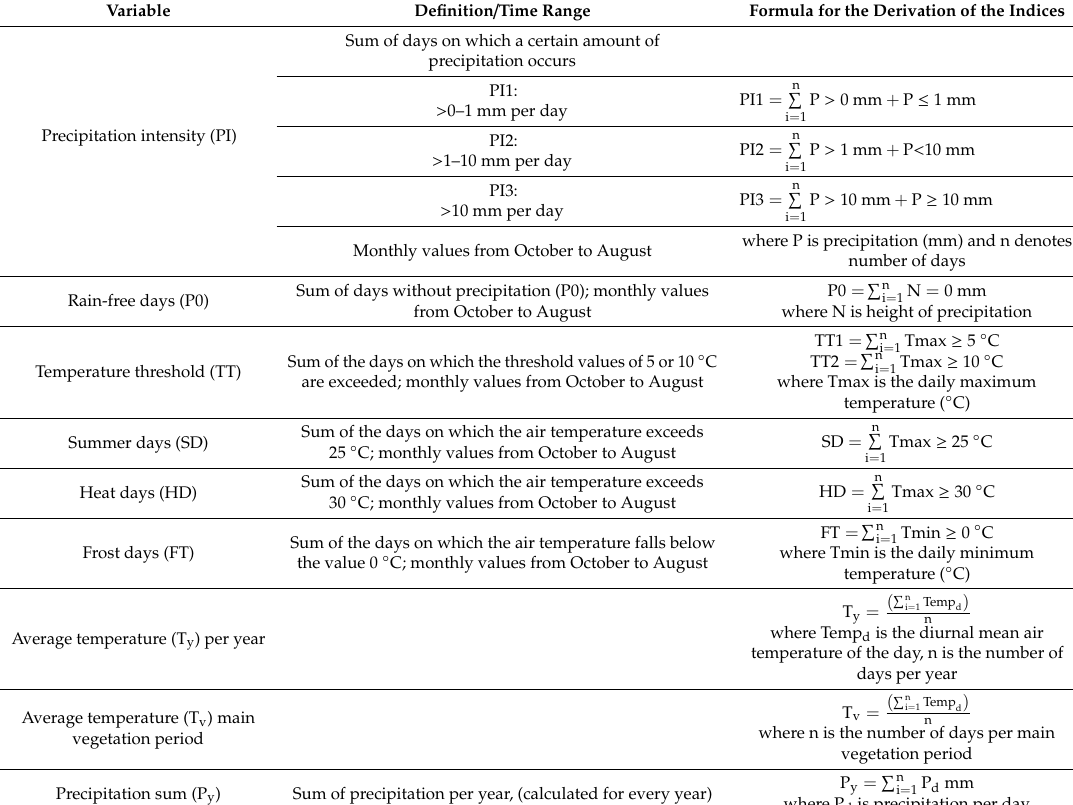
Table 4. Overview of the climate variables used in this